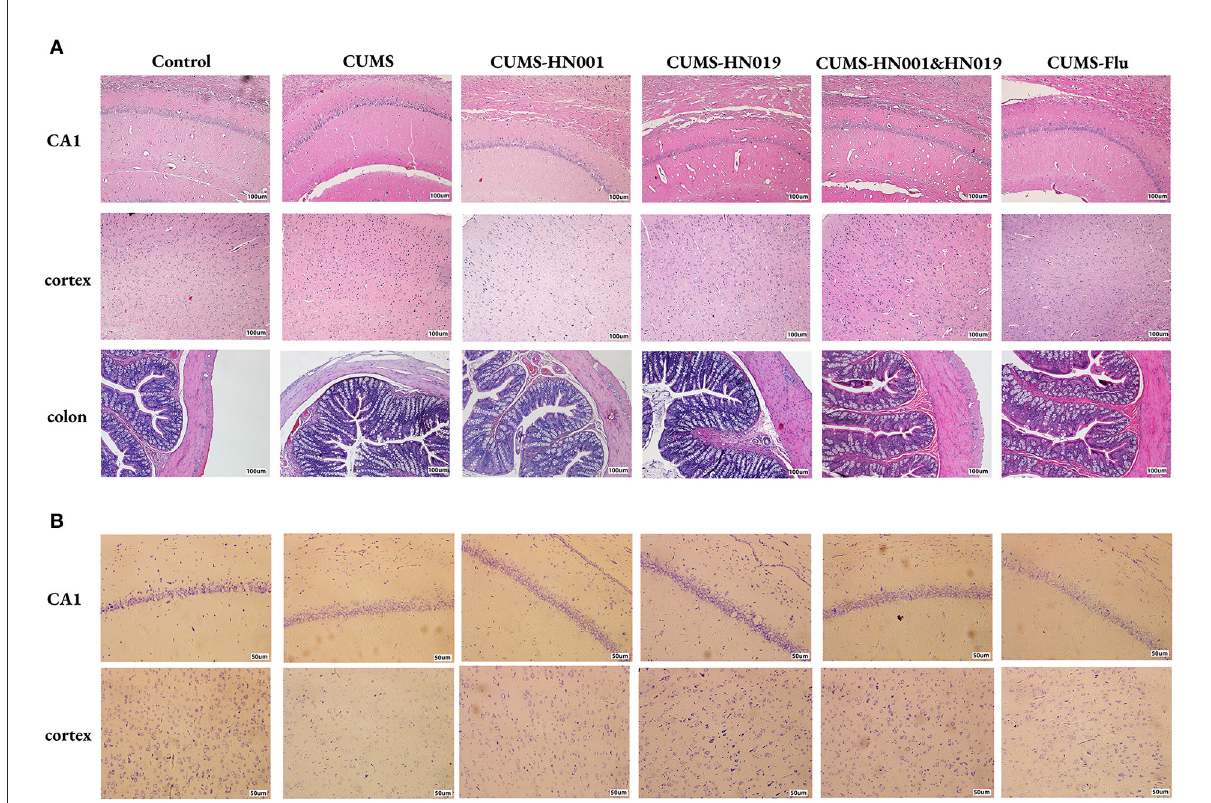
FIGURE3 Probiotics supplementation improved the histological variations in rat hippocampi and colon. Representative micrographs of hippocampus, cortex and colon labeled with HE staining (A) . Scale bar = 100 µ m. Neurons in hippocampus and cortex were assessed by Nissl staining (B) . Scale bar = 50 µ m ( n = 3 brains/group).